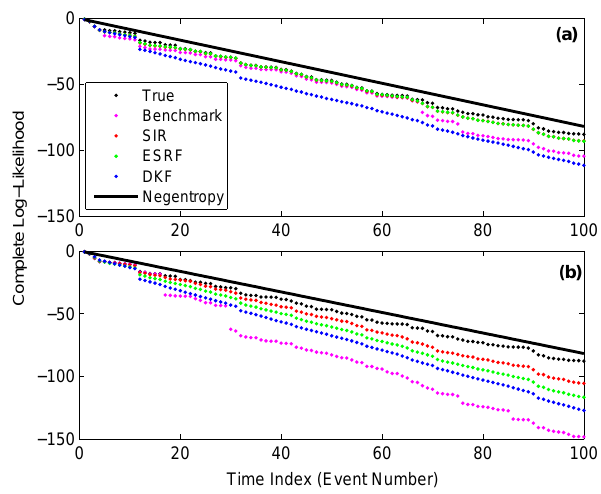
Fig. 3. Evolution of the cumulative complete marginal log- likelihood of the particle and Kalman filters and the benchmark for the case of (a) uniformly distributed and (b) Gaussian mixture dis- tributed observational errors. Also shown are the log-likelihoods of the “true” (unobservable) times using the “true” event times (black) and the average log-likelihood given by the negative entropy of the lognormal distribution (solid black line). In (a) , the scores of the SIR and EnSRF are